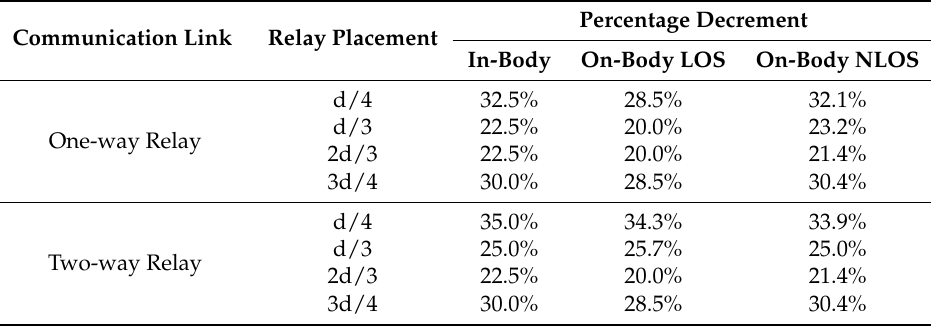
Table 4. Relay placement.